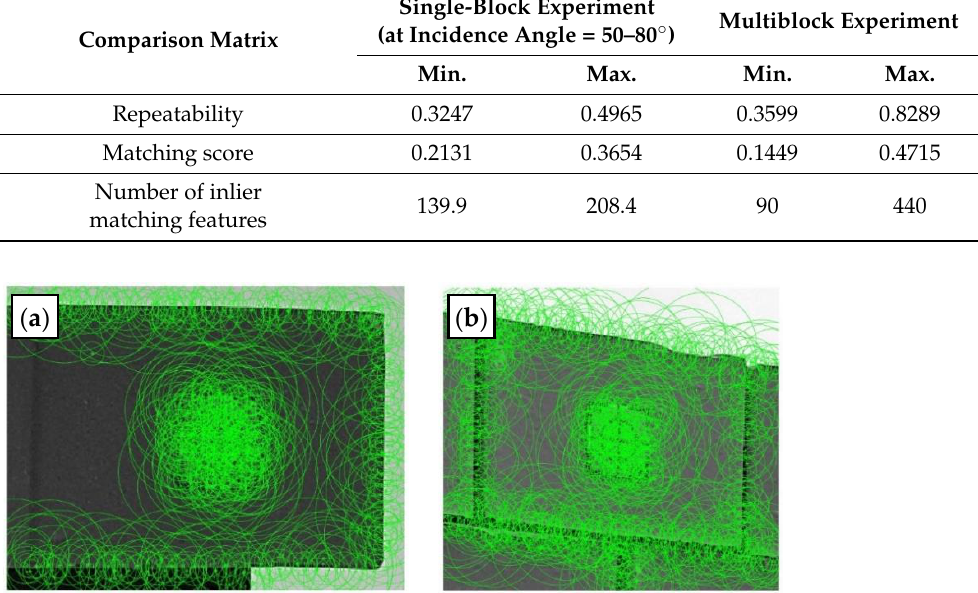
Figure 13. Examples of extracting features at facing displacement. ( a ) Single block (pixel size: 350 × 268); ( b ) Block (part 2) in multiple blocks (pixel size: 330 × 298). Table 2. Minimum and maximum values for the feature performance evaluation measured from the single- and multiblock experiments.